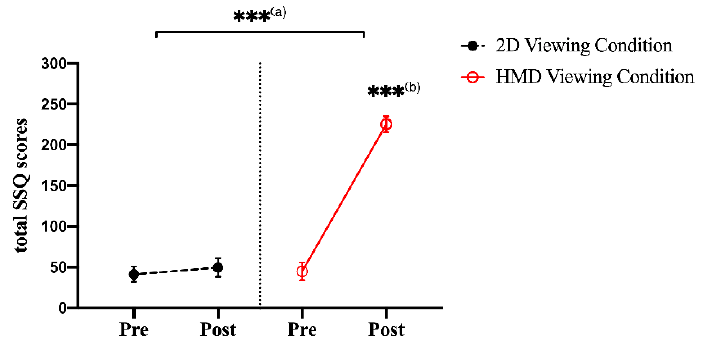
Figure 3. Representation of the total SSQ scores for motion sickness between the 2D and HMD conditions. There was a significant difference based on a paired t -test and ANCOVA (*** p < 0.001). ( a ) The ANCOVA test between the 2D and HMD viewing condition. ( b ) A paired t -test between pre- and post-viewing in the HMD condition.